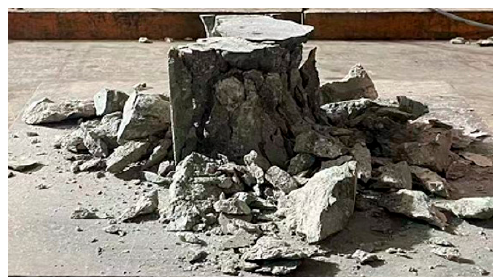
Figure 2. Strength test of the concrete block.